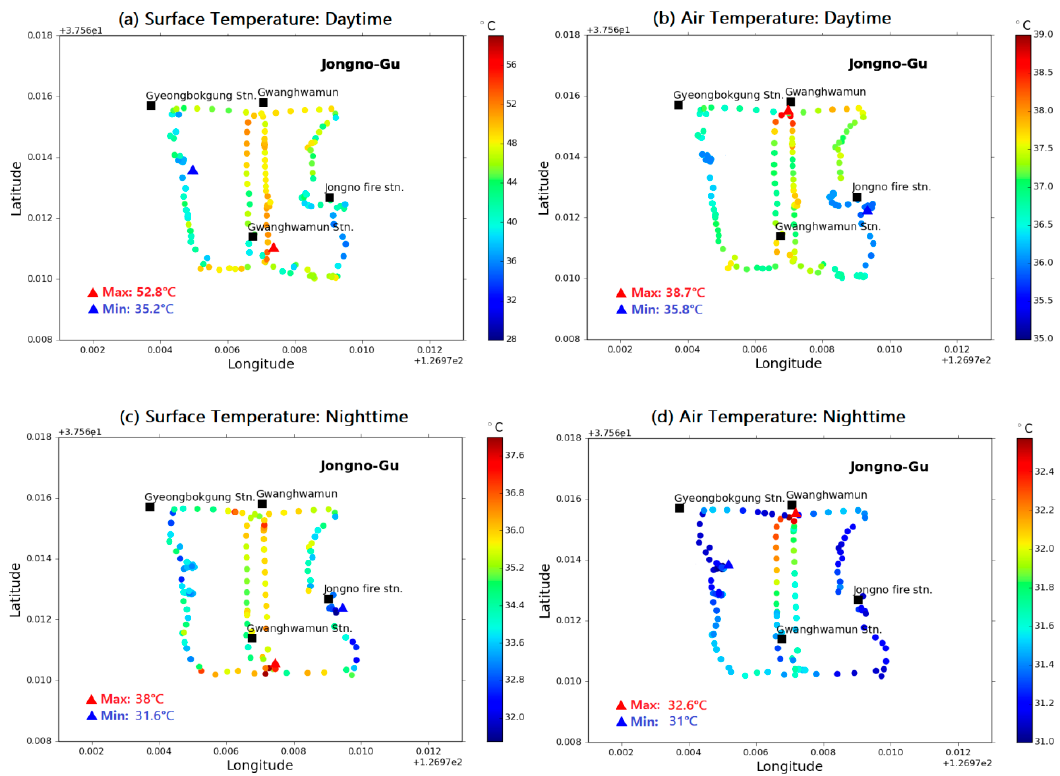
Figure 6. Spatial distributions of road surface temperature (RST) and air temperature from MOVE observations during the ( a , b ) daytime (1547–1602 LST) and ( c , d ) nighttime (2047–2114 LST) on 6 August, 2019. The color bars represent different temperature ranges.